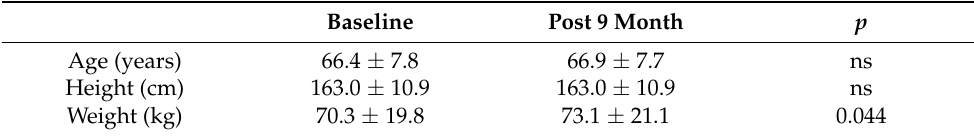
Table 1. Descriptive characteristics of the included patients.